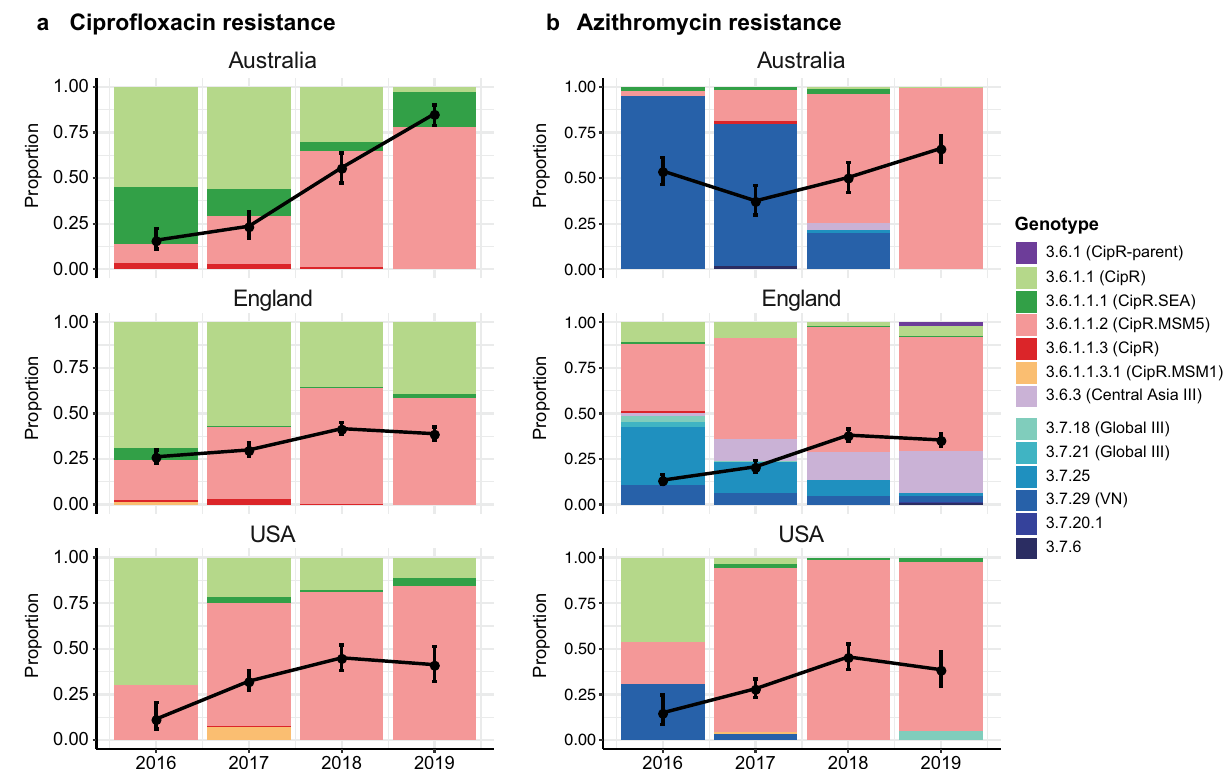
Fig. 4 Prevalence and genotype breakdown of cipro fl oxacin and azithromycin resistant S. sonnei in three surveillance regions (Australia, England and USA) from 2016 to 2019. In each plot, black lines indicate the proportion of genomes that are predicted resistant to ( a ) cipro fl oxacin (de fi ned as presence of ≥ 3 QRDR mutations) or ( b ) azithromycin (de fi ned as carrying mph (A)). Error bars indicate 95% con fi dence intervals for the proportion resistant ( n = 144 – 182 for Australia, n = 610 – 869 for England, n = 87 – 313 for USA). Stacked bars indicate the relative abundance of each genotype among resistant isolates, coloured by genotype as per